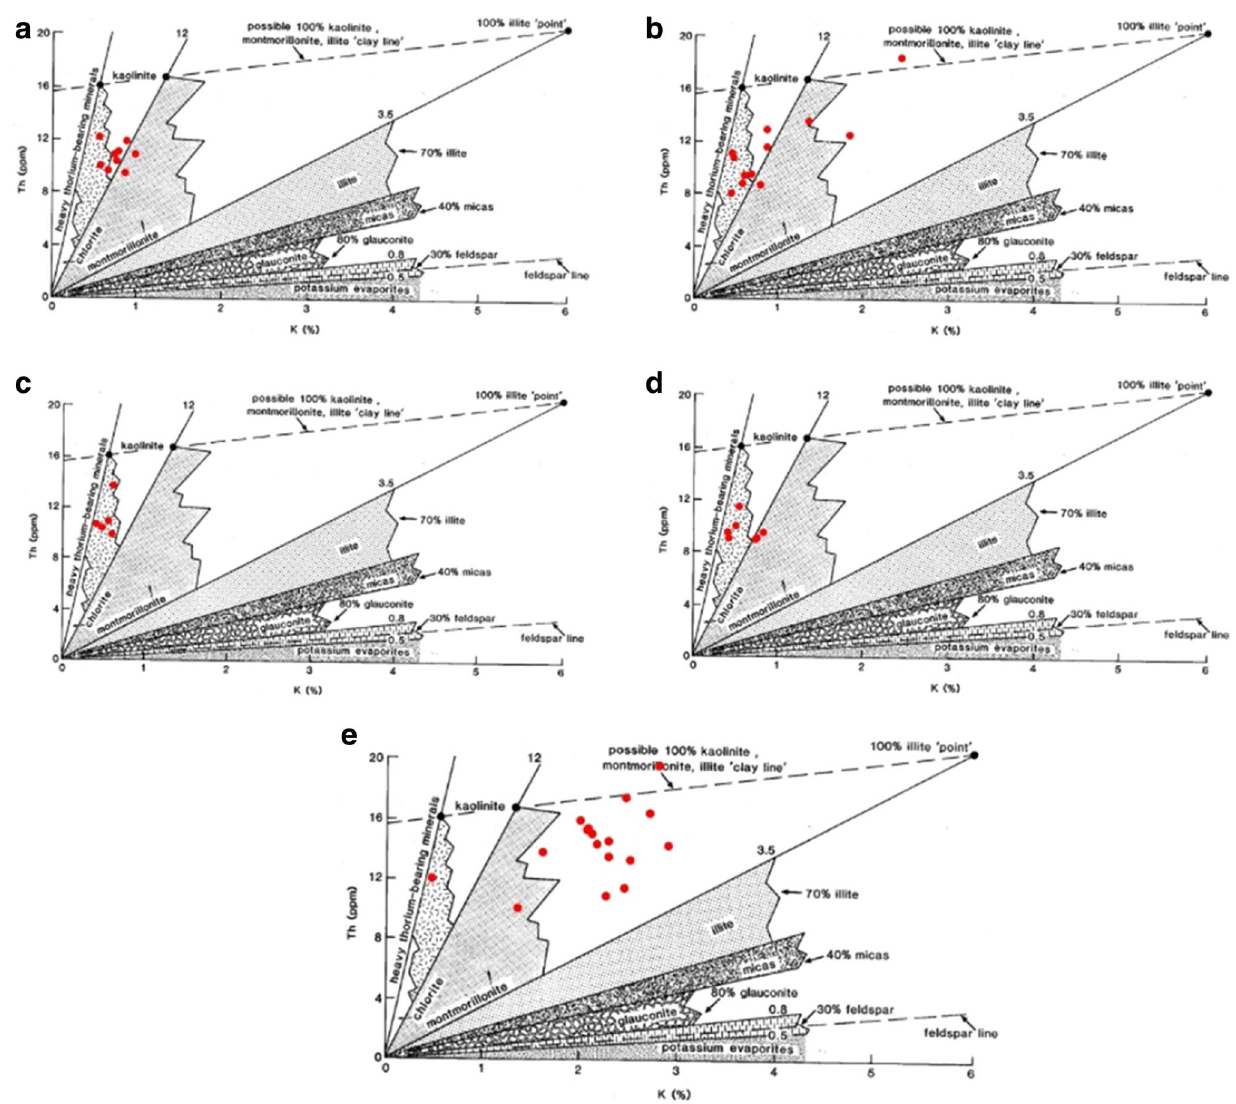
Fig. 2 Mineralogical charts of Th/K ratio cross plots for identification of clay minerals. a Nyalau Formation, b Tatau Formation, c Begrih For- mation, d Liang Formation and e Belaga Formation (Quirein et al.